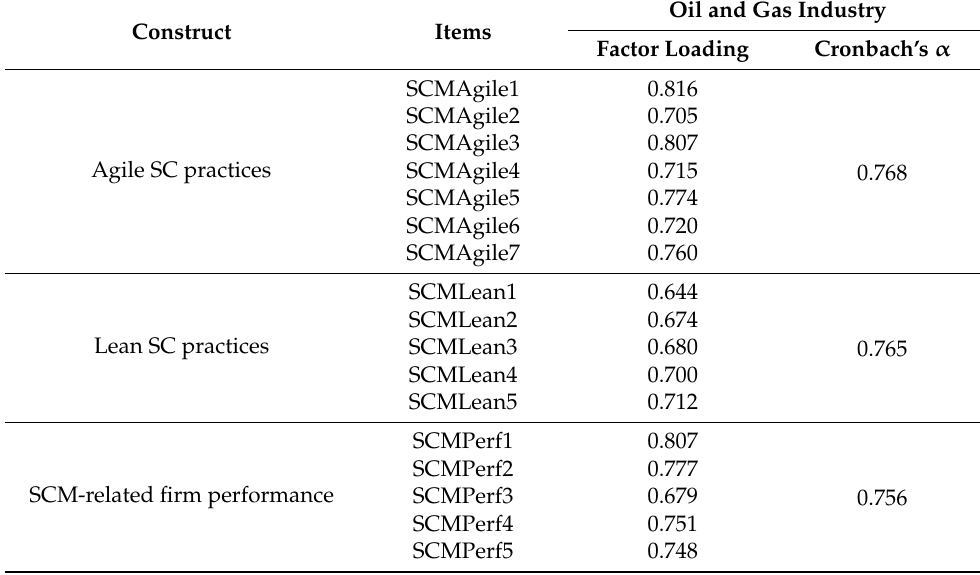
Table 3. Factor loading and reliability